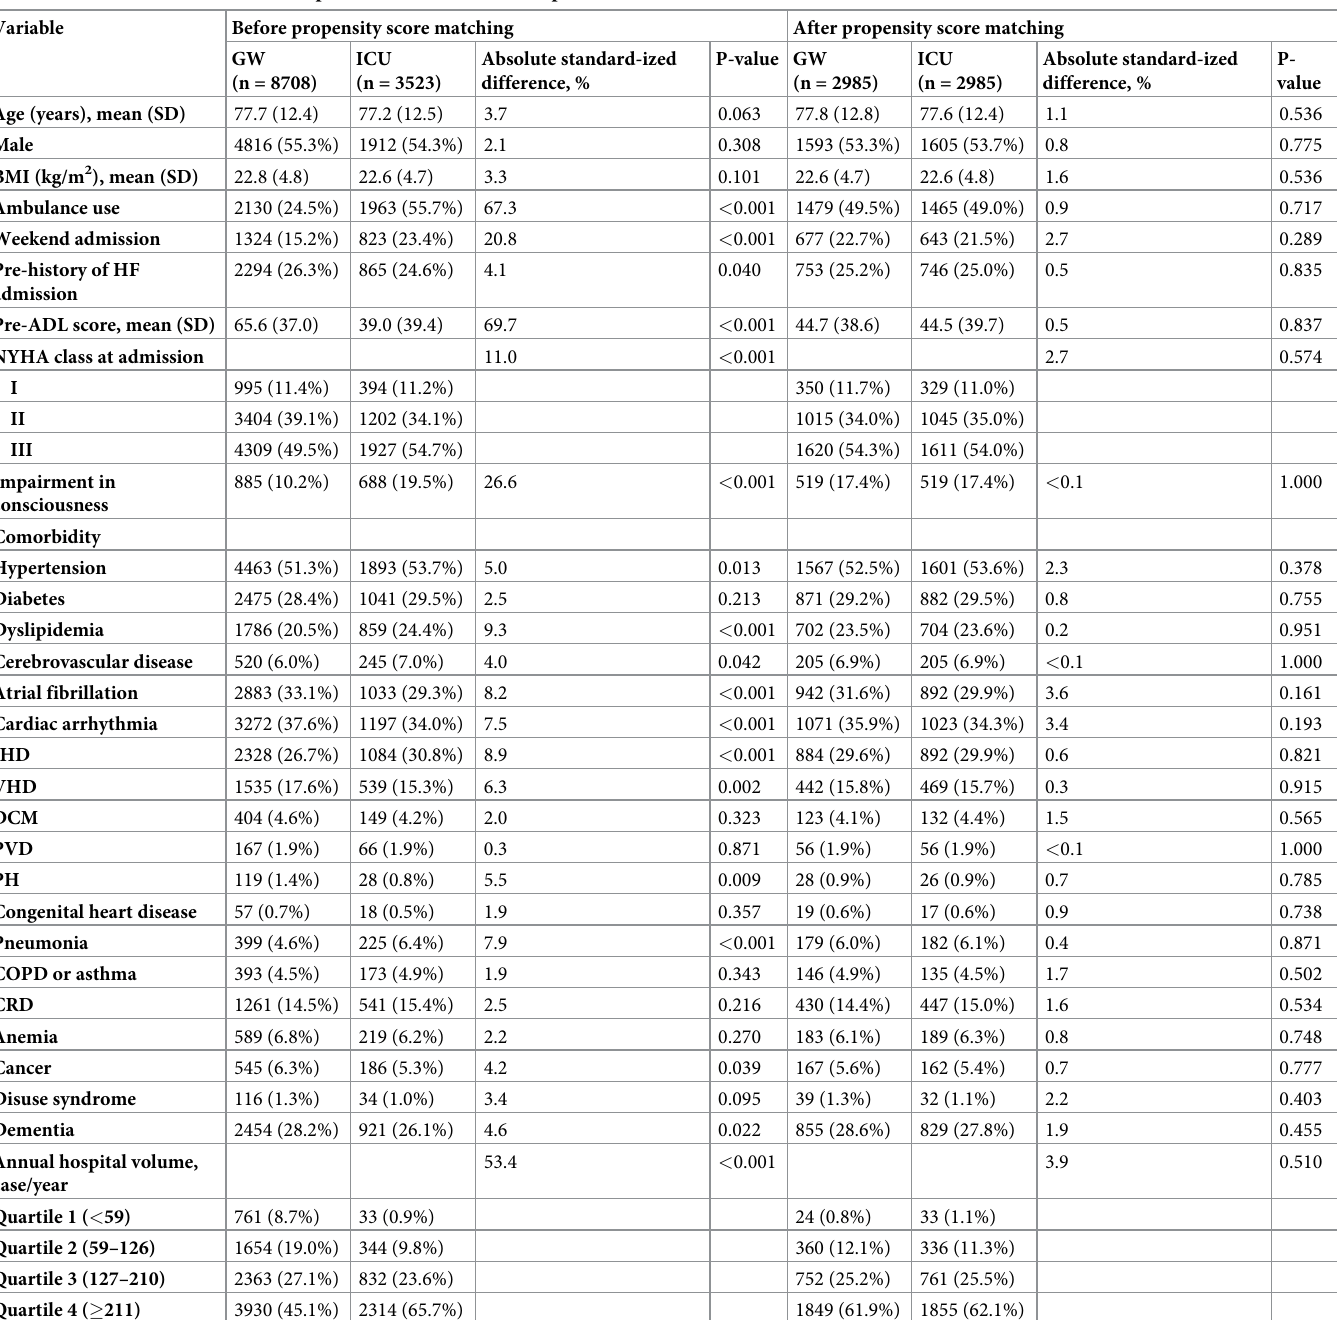
Table 1. Baseline characteristics of the pre-match and matched